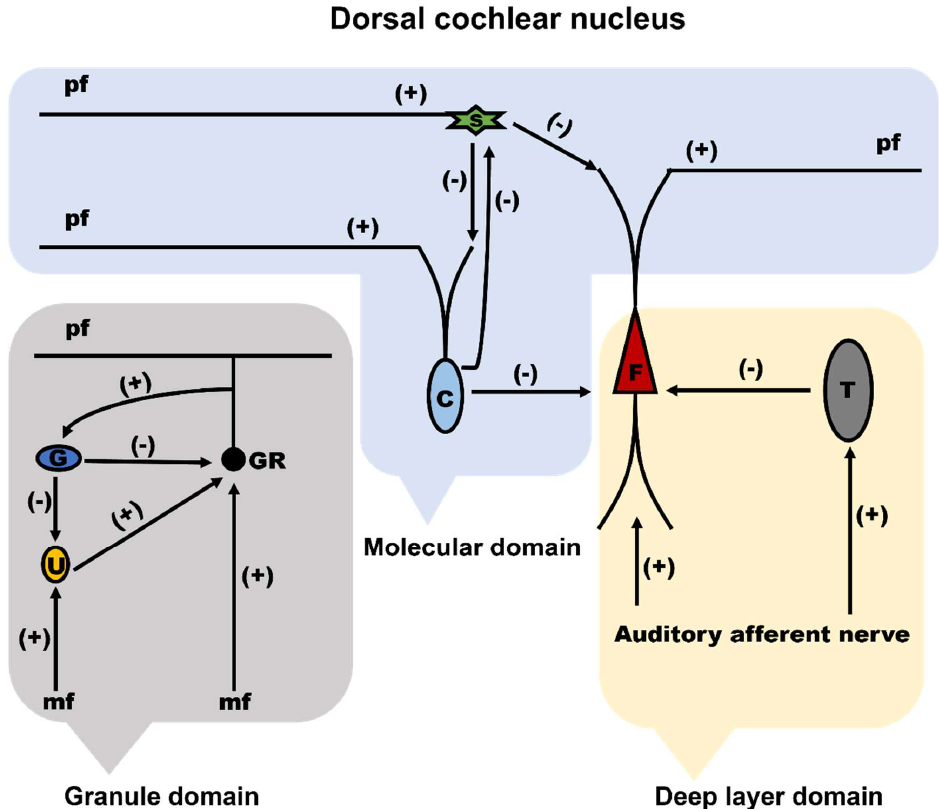
Figure 3. Cerebellum-like circuit domains in the DCN. Excitatory (+) and inhibitory (-) components are represented within the three functional domains of DCN, which are entitled as molecular domain, granule domain, and deep layer domain. This figure is adapted according to the published study of the ref. [36]. mf, mossy fibers; pf, parallel fibers; F, fusiform cell; G, Golgi cell; U, unipolar brush cell; s, stellate cell; C, cartwheel cell; T, tuberculoventral cell; GR, granule cell. The supporting evidence of similar features of the DCN and cerebellum are present in the mouse models with neurological mutations, such as Purkinje cell degeneration (pcd), staggerer, and lurcher mouse models [39–44]. Cerebellar defects as a typical feature are accompanied in these mouse models. Some results have been observed in earlier in- vestigations on these mice, indicating that the DCN might have cerebellum-like microcir- cuitry. Previous studies have shown that the complete population of axons in Purkinje cells of the postnatal pcd mice begins to deteriorate at two weeks. Similarly to the occur- rence of abnormality of cerebellar Purkinje cells, axonal clusters produced by cartwheel cells were essentially eliminated in the pcd mice [39–44]. For the staggerer mice, few Purkinje cells could survive into adulthood because Purkinje cell dendritic growth was unsuccessful. Delayed formation of dendritic spines was observed in some surviving cart- wheel cells in adult staggerer mice [39–44]. Nearly all the cerebellar Purkinje cells degen- erated in the postnatal week of a mouse model known as lurcher mice. The vast majority of cartwheel cells of the lurcher mice undergo degeneration which is observed together with the degeneration of Purkinje cells [39–44]. These results are strong evidence that the genetic developmental program in both cell types may well be comparable. This compar- ation is further achieved in recent years, and supporting evidence is emerging at the level of cellular genetics (Figure 4). According to cell lineage studies, many cell types in the DCN and cerebellum are defined as serial sister cell types, meaning that they share same